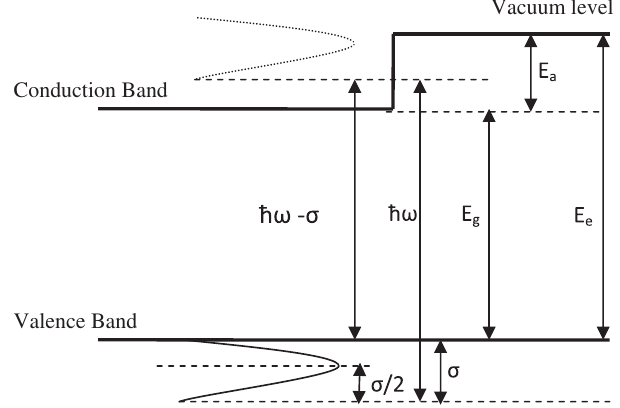
FIG. 5. The probability distribution of the electrons in the band structure of the crystal. The solid parabola is the electron energy probability distribution in the valence band, while the dashed parabola curve is the electron energy probability distribution after being excited to the conduction band. σ is the width of the band below the maximum of the valence